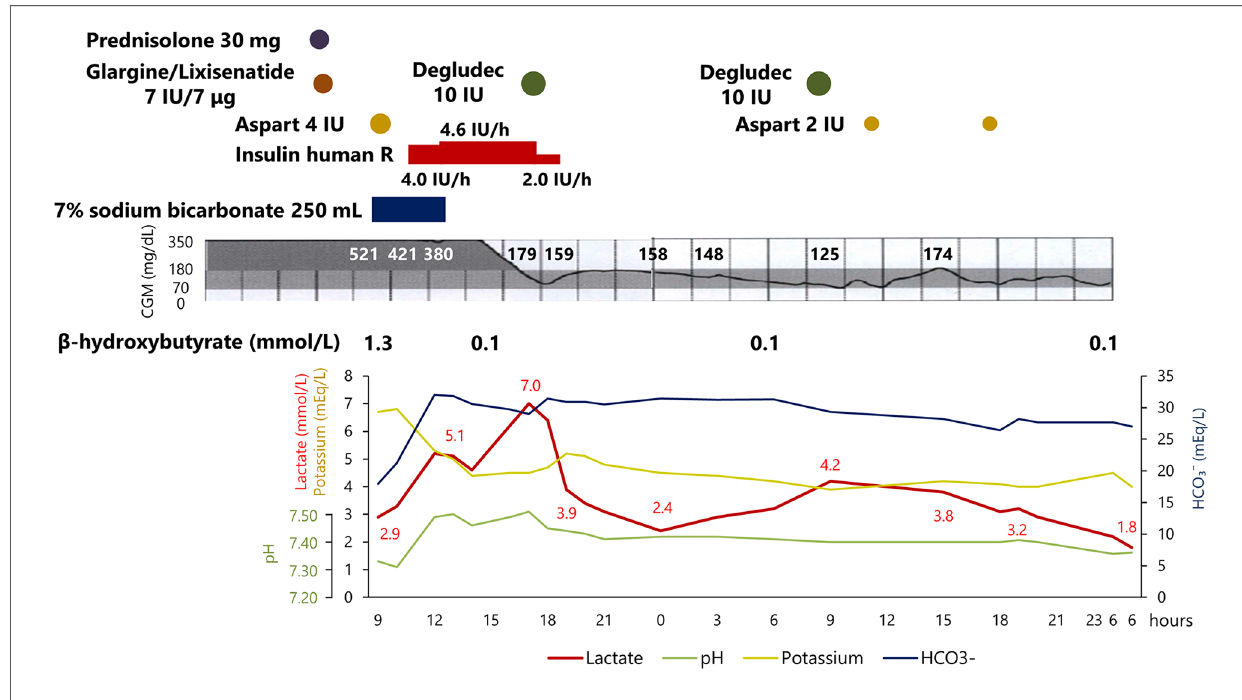
FIGURE 1 Time course of clinical features and